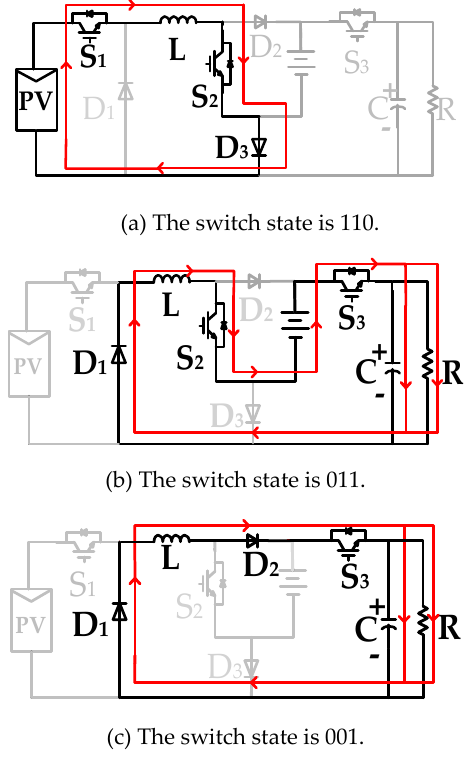
Figure 7. Working states of DISO mode.